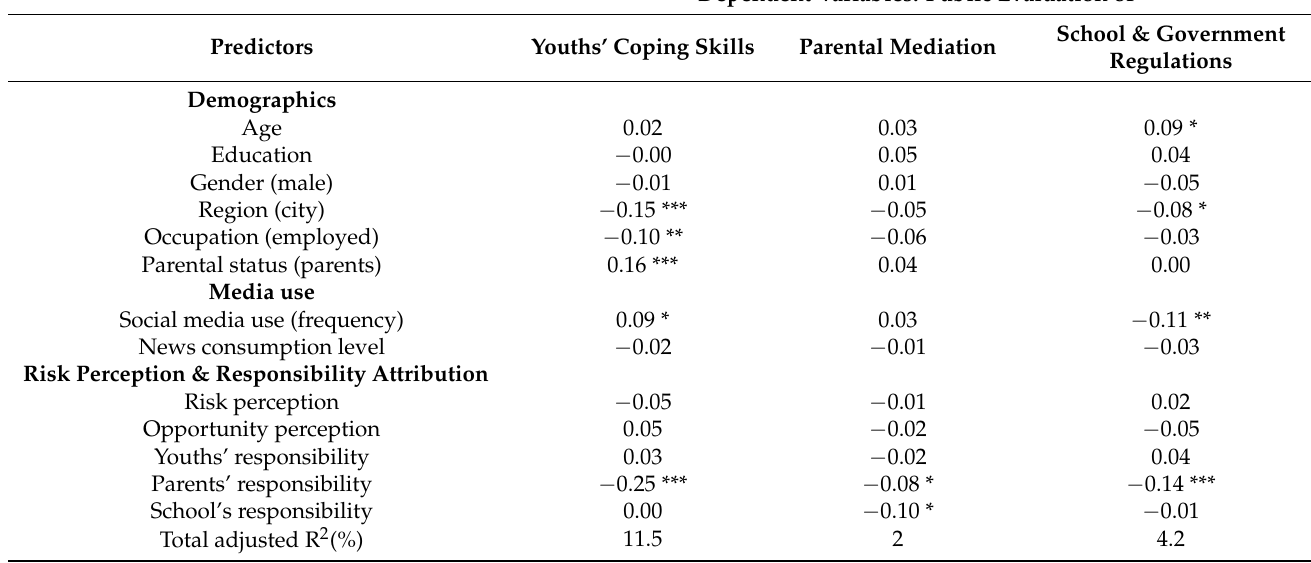
Table 4. Multiple regression analyses predicting the public’s evaluation of adolescents’ coping skills, parental mediation, and school and government interventions (standardized